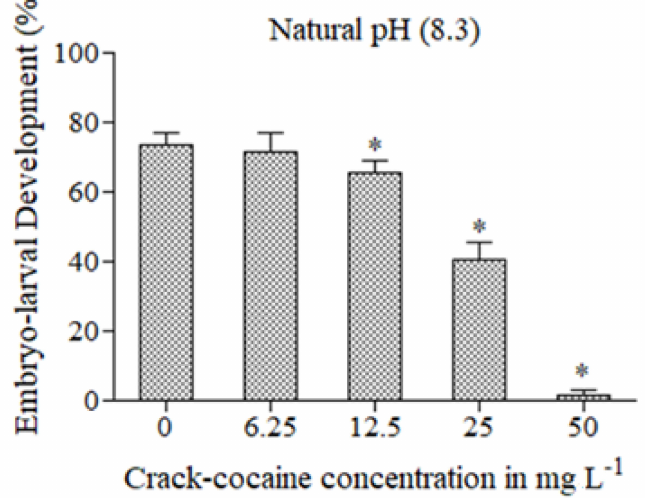
Figure 4. Perna perna embryo–larval development results after exposure to the different CC concen- trations in reconstituted seawater (pH 8.3) without acidification and considered as negative control. Asterisks indicate significant differences ( p <